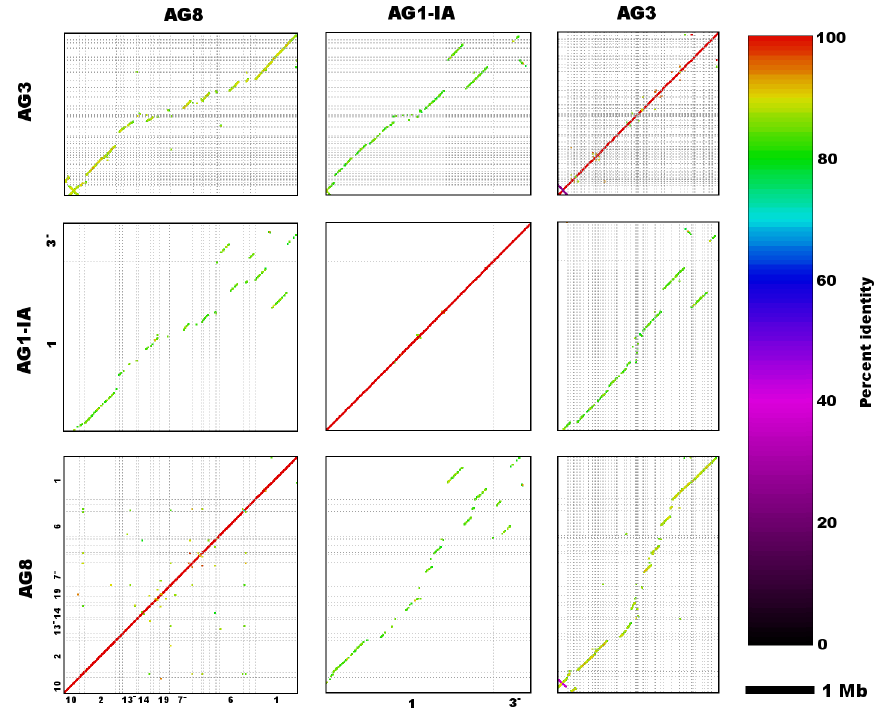
Figure 3. Genome assembly sequence comparisons between R.solani AG8 and isolates from alternate anastomosis groups. Dot-plots depict nucleotide sequence matches detected via MUMmer (nucmer) between the two largest scaffolds (both Scaffold_1) of R. solani AG8 and AG1- IA, as well as other homologous scaffolds from AG8, AG1-IA and AG3. Sequence alignments exhibit a predominantly co-linear, macrosyntenic configuration, however a small number of structural rearrangements can be observed between the larger scaffolds of AG8 and AG1-IA. Due to partial assembly of these genomes and thus short length of many scaffold sequences depicted here, only longer scaffolds have been labelled with their numbers along the x- and y-axes, however full details of alignments can be found in Supporting Table